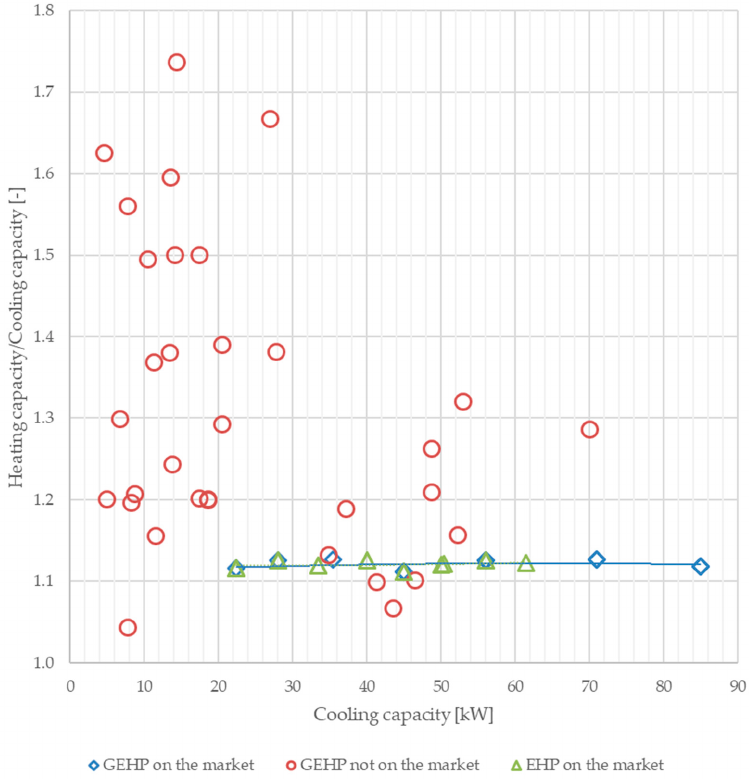
Figure 9. Ratio between heating and cooling capacity for both GEHPs and EHPs.